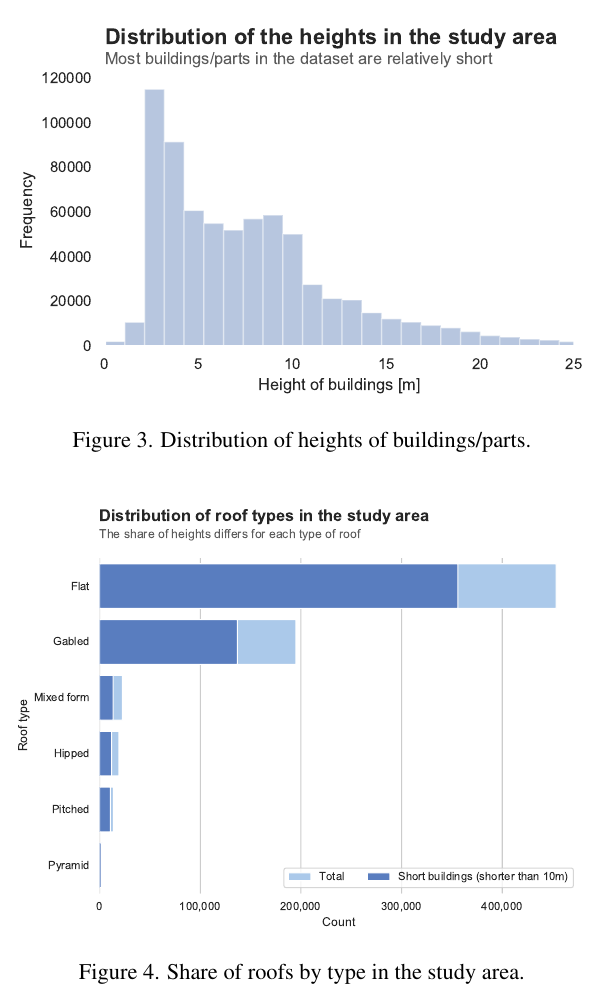
Figure 5 further indicates the relevance of including the